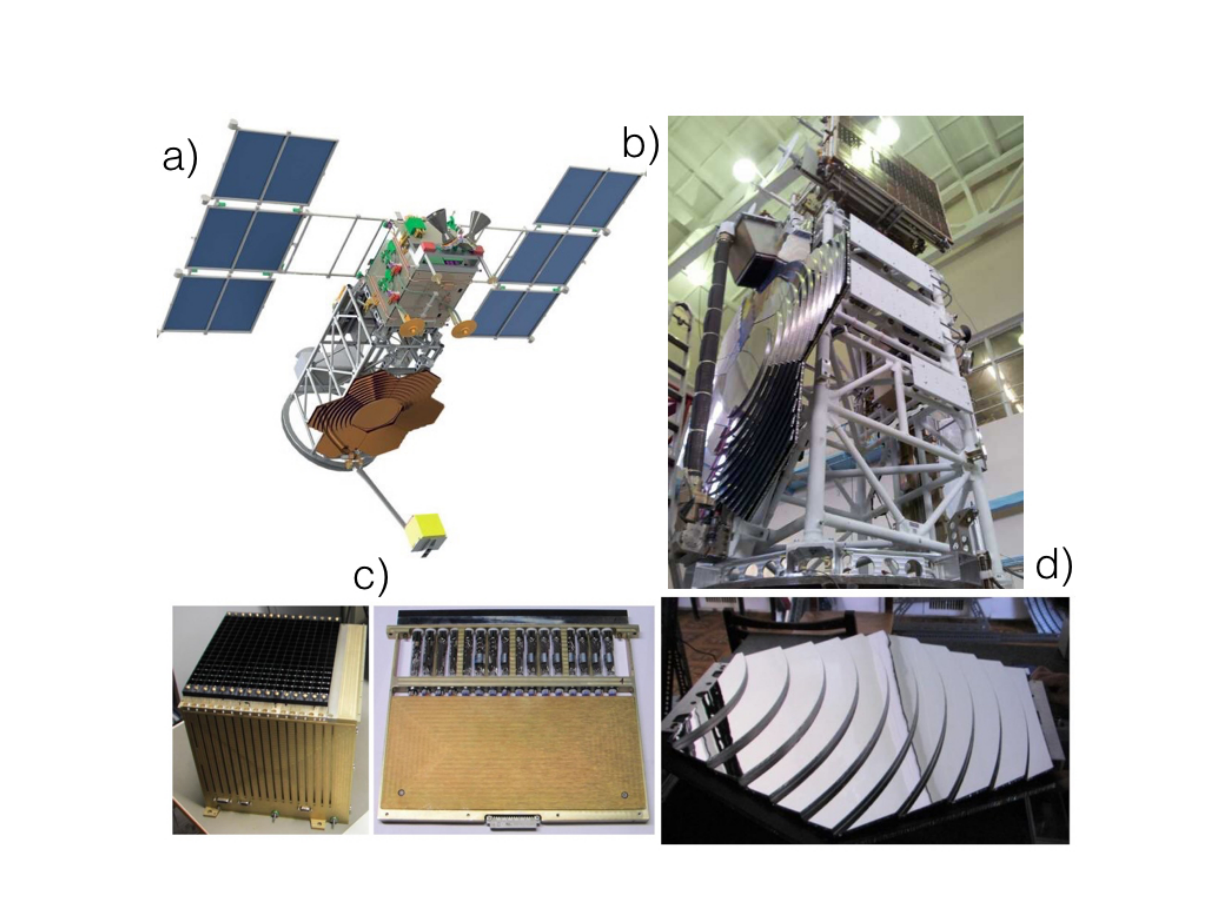
Figure 1. a) Artist’s view of the TUS detector on board the Lomonosov satellite; b) TUS on board the Lomonosov satellite during preflight preparations at cosmodrome Vostochny; c) TUS Focal Surface; d) TUS Fresnel